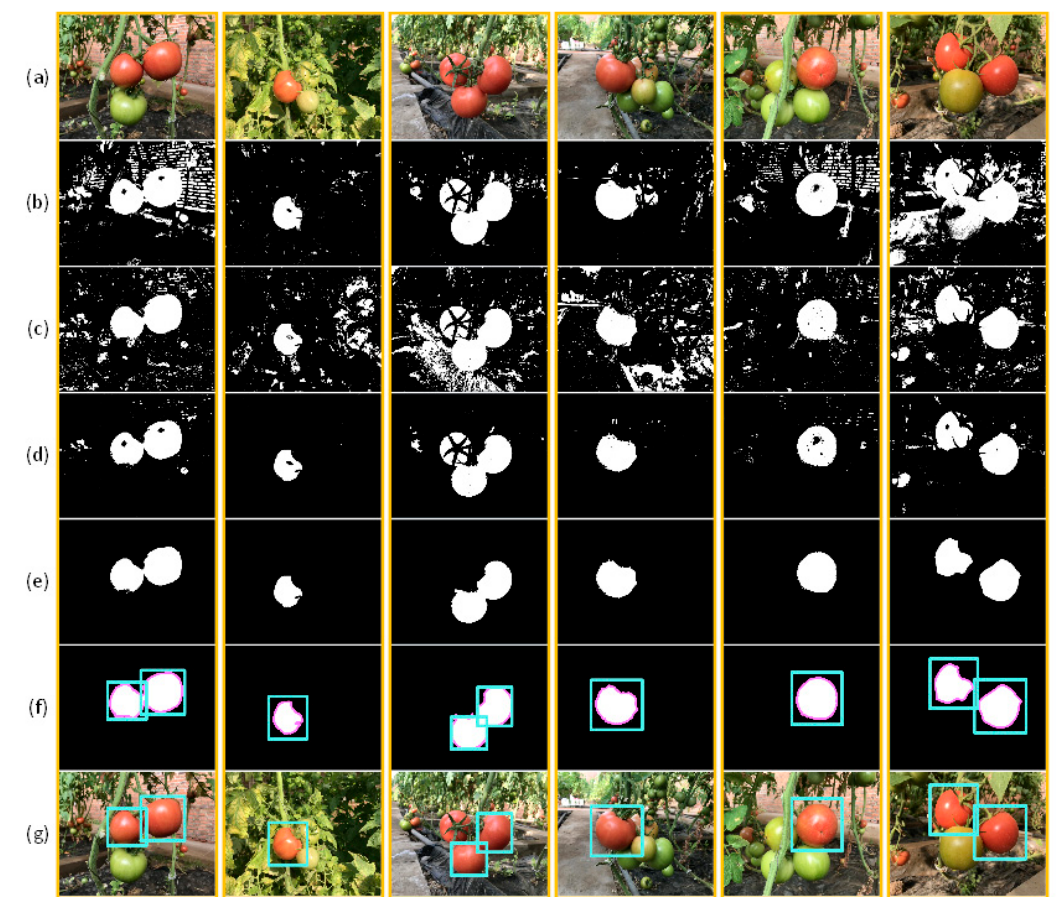
Figure 9. Process diagrams for sections in the algorithm. ( a ) Example images of ripening tomatoes. ( b ) Result of the first layer strategy based on the chromatic difference analysis. ( c ) Result of the second layer strategy based on the weighted RVM classifier. ( d ) Result of combining the two classification steps. ( e , f ) Results obtained after small areas were filled and contour detection. ( g ) Result obtained after marking the original image.